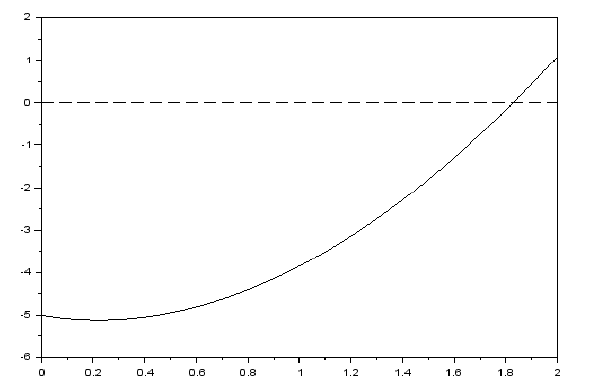
Figure 2. The shape of f(T) defined by (21) if C D > 2(C I + C R